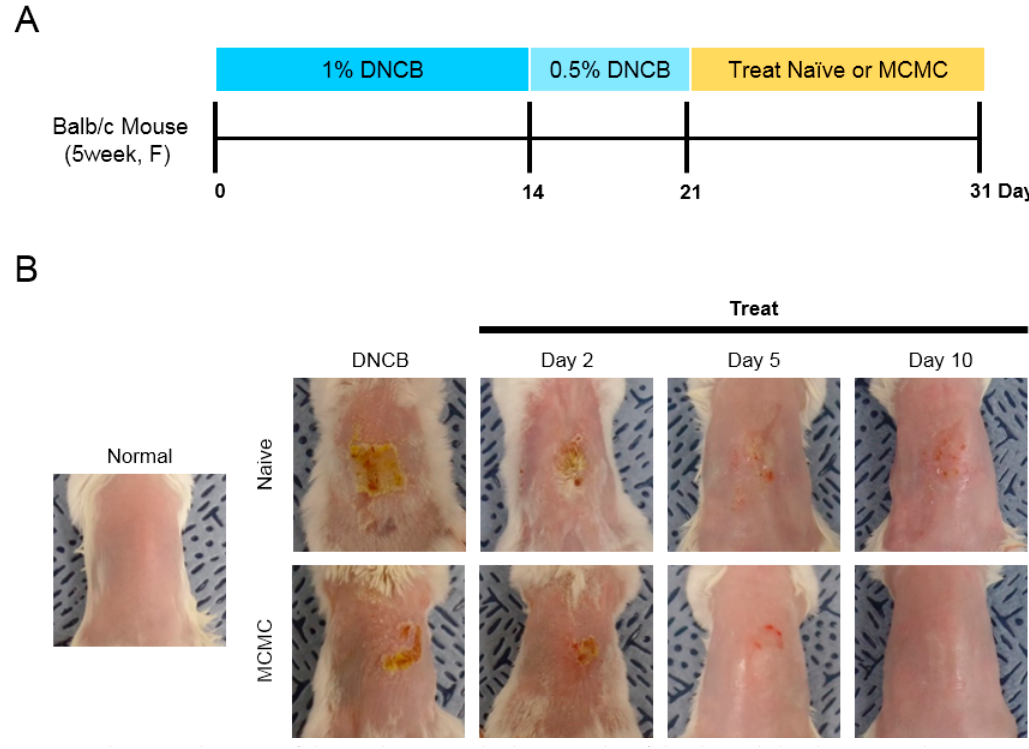
Figure 2. Schematic diagram of the study protocol, Photographs of the dermal skin lesions. Induction and treatment of AD (atopic dermatitis)-like skin lesions in mice. ( A ) Schematic diagram of the study protocol. To induce atopic dermatitis-like lesions, DNCB (1-chloro-2,4-dinitrobenzene) was applied ectopically to Balb/c mice. A total of 80 μ L of 1% DNCB in sunflower oil was applied for 2 weeks, and 80 μ L of 0.5% DNCB was applied for 1 week. Mice were then treated with 80 μ L of MCMC (M-MSC conditioned media concentrate) or naïve media for 10 days. ( B ) Representative macroscopic dorsal skin lesions. MCMC showed therapeutic effects on DNCB-induced AD-like skin symptoms.